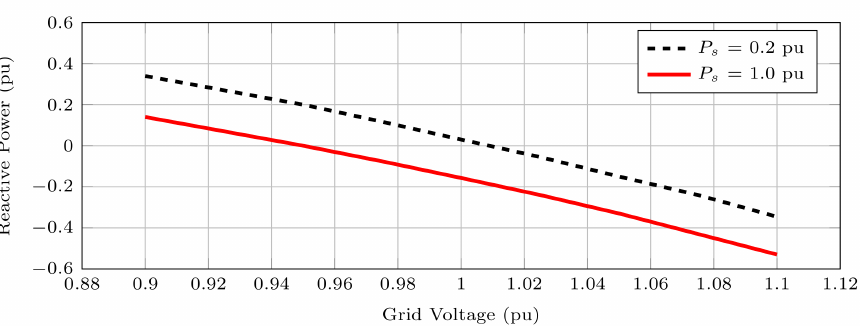
Figure 12. Steady-state reactive power versus grid voltage with supply power as a parameter.